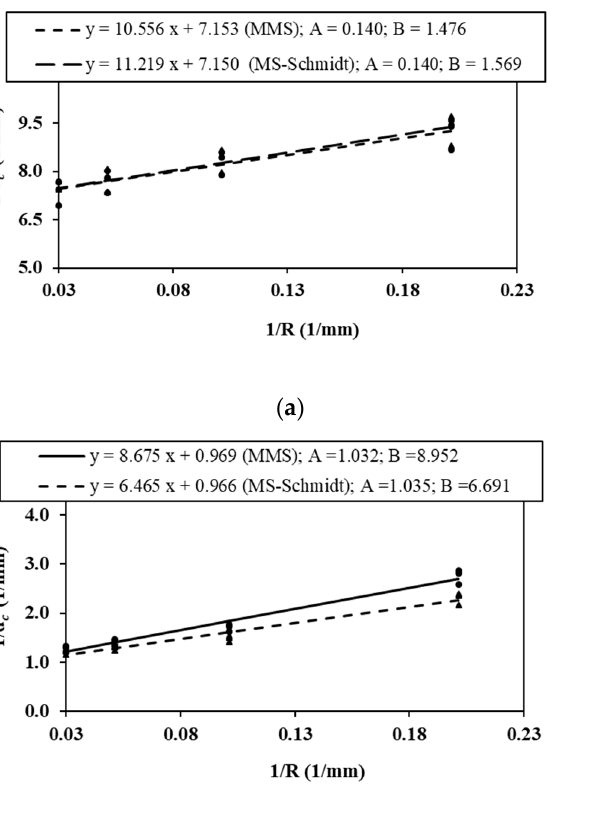
Figure 7. Variation in K IcV, ρ with specimen size for RVNBD specimens made of PMMA. Predictions provided by the MS–Schmidt and the MMS criteria, and experimental data.